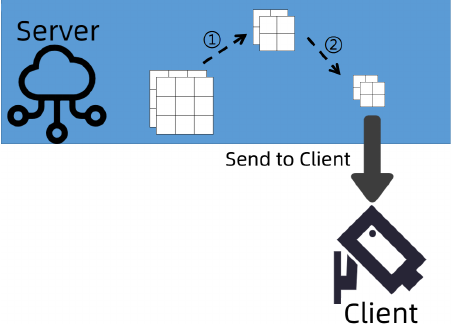
Figure 3. Server to Client. (1) The sub model is constructed through Federated Dropout, and (2) the generated objects are lossless compressed to reduce the size of the communication